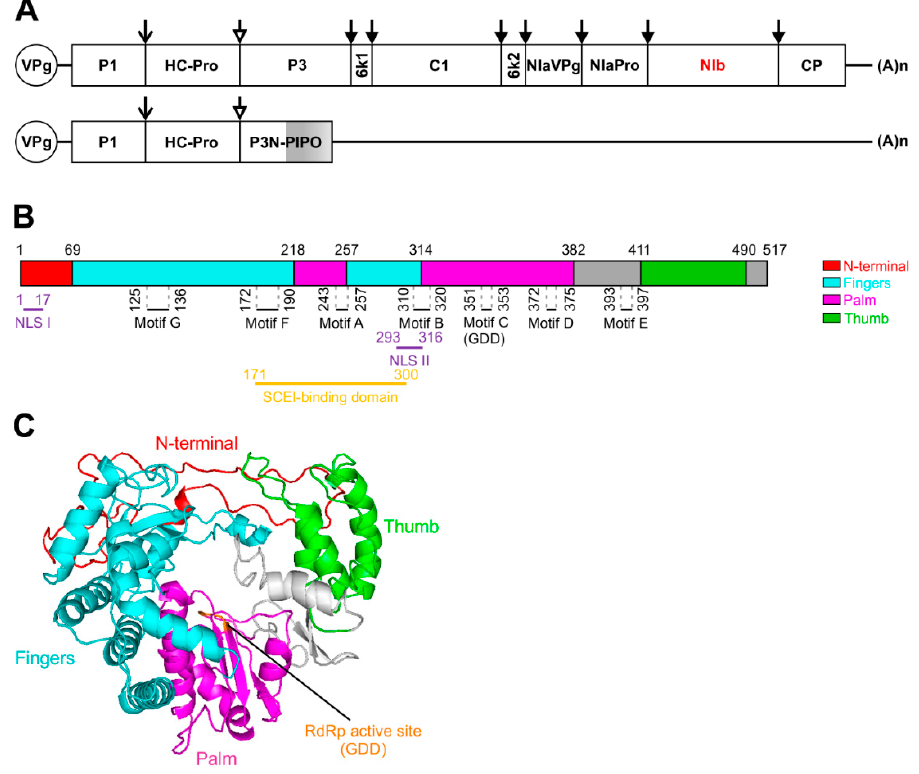
Figure 1. Schematic representation of the Turnip mosaic virus (TuMV) genome and the predicted structure of the TuMV nuclear inclusion b (NIb). ( A ) Schematic representation of the TuMV genome. The circle represents the genome-linked viral protein VPg, and (A) n represents the poly(A) tail. The open reading frame (ORF) is indicated as a long box. Mature proteins resulting from polyprotein processing are indicated by smaller boxes. PIPO derived from a frameshift on the P3 cistron is